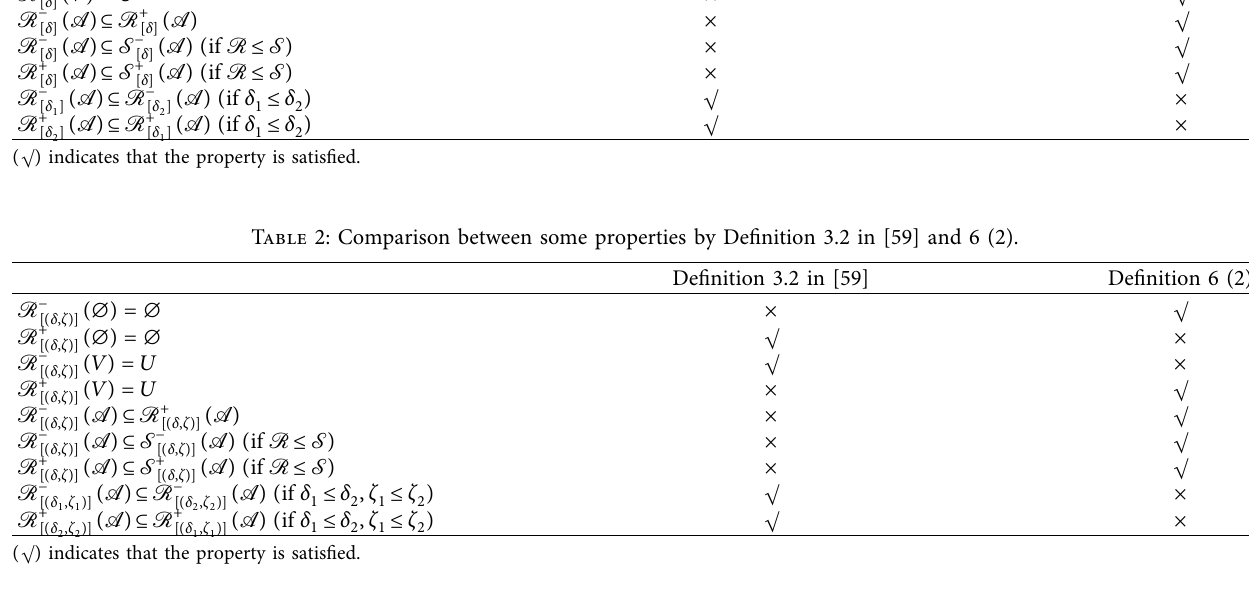
Table 3: Comparison between some properties by Definition 3.3 in [60] and 6 (3).